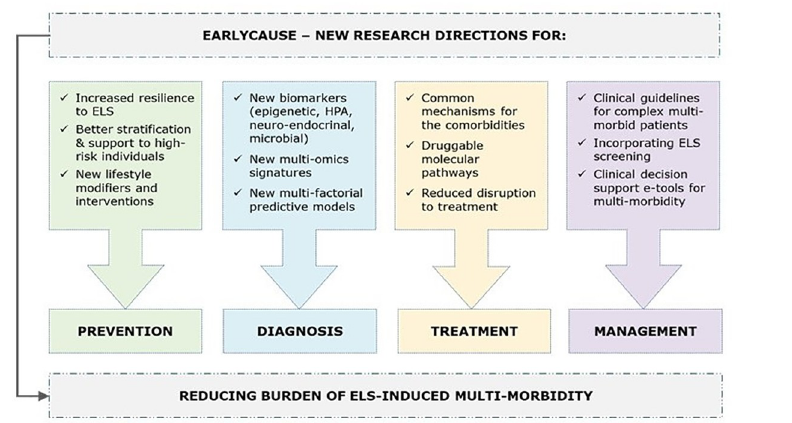
Fig 7. Overview of the research directions affected by